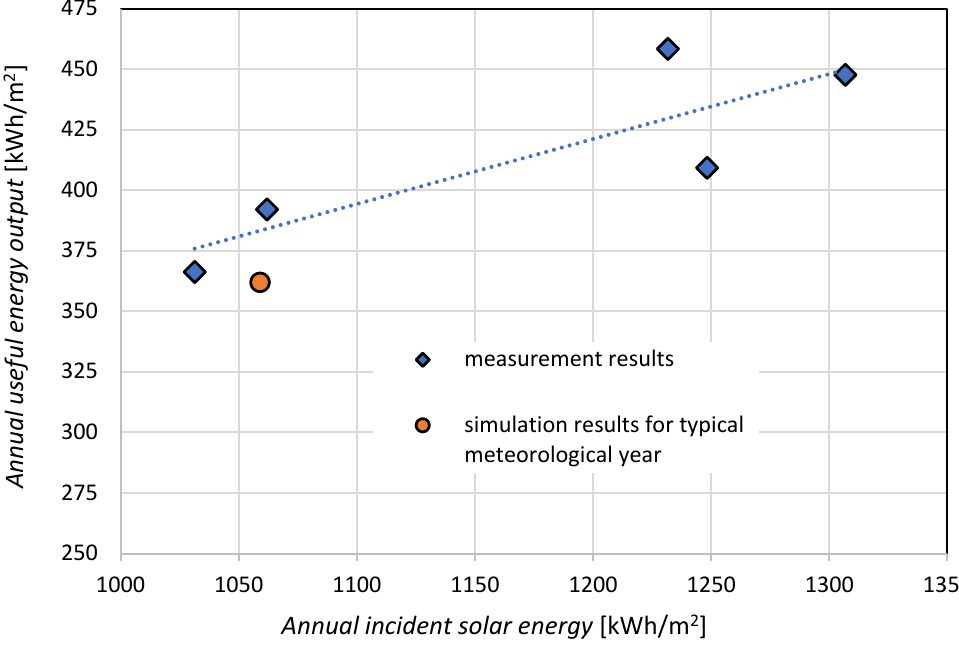
Figure 3. Dependence of annual useful energy output on the intensity of solar radiation for the FPC collector system.